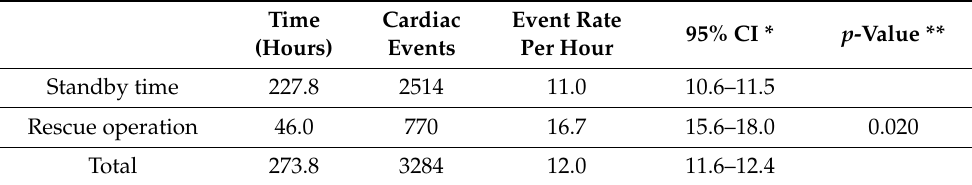
Table 4. Cardiac event rates (total, standby time, rescue